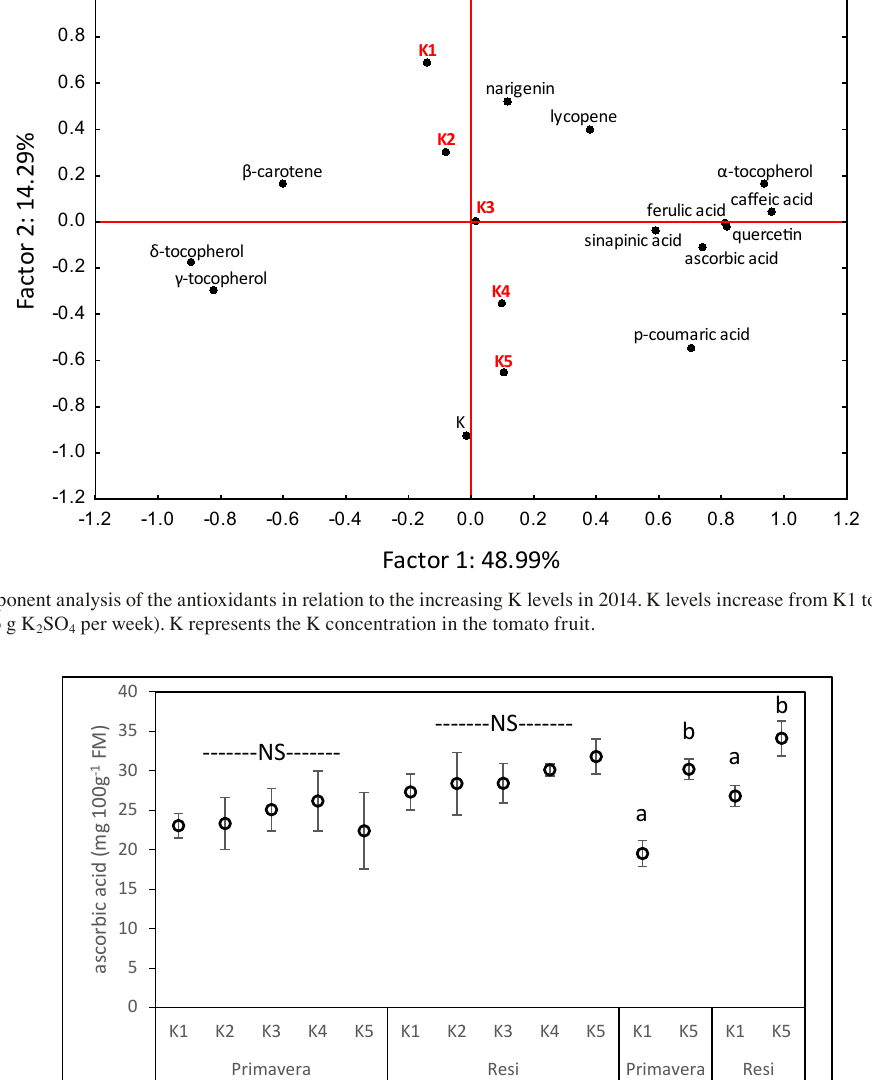
α -tocopherol β -carotene